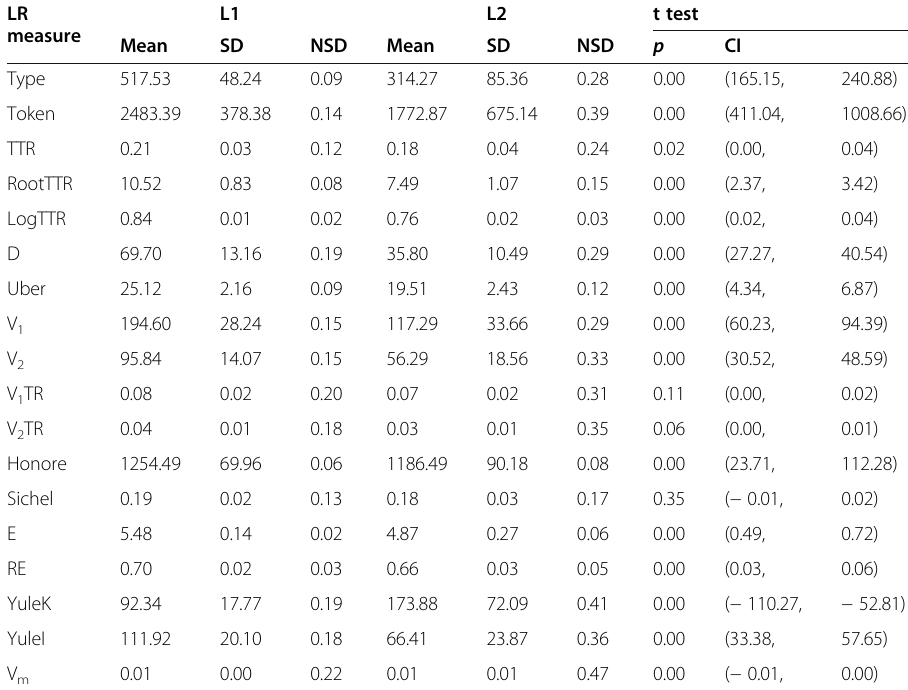
Table 3 ANOVA statistics for comparison of LR difference by characters in L1 and L2